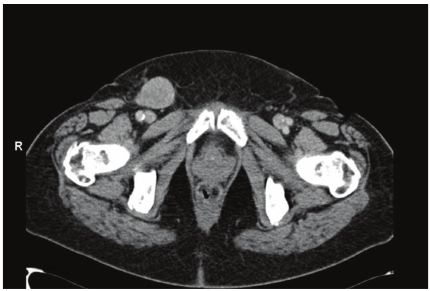
Figure 3: A 68-year-old Caucasian woman with a high grade sarcoma NOS presenting with a RLNM.